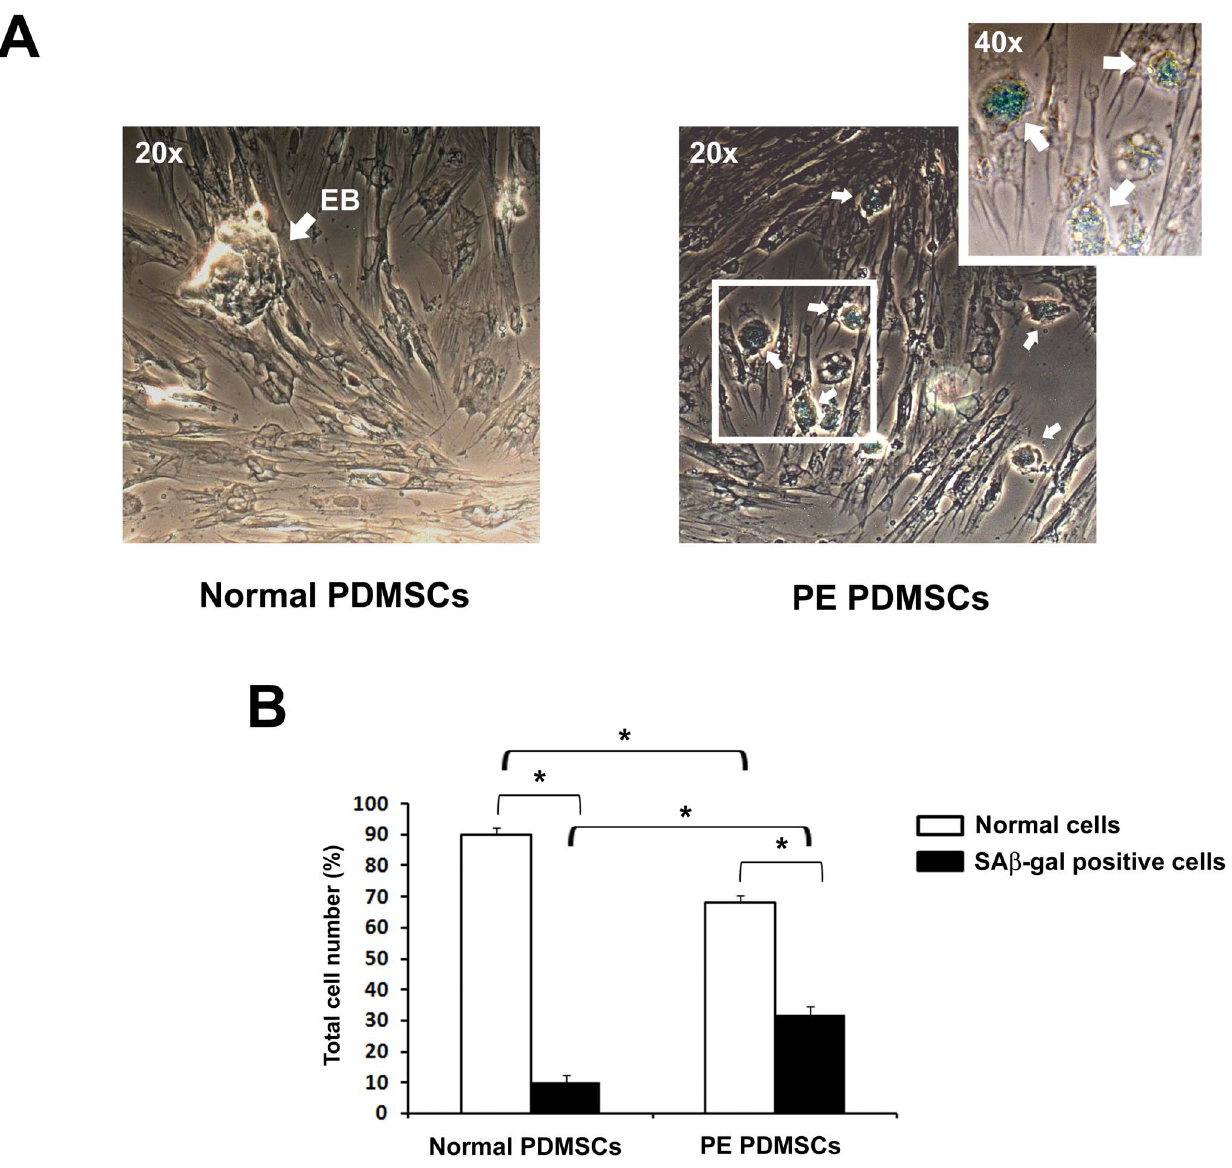
Figure 2. Senescence quantification in PDMSCs isolated from normal and preeclamptic placentae. (A) Normal (left panel) and PE (right panels) PDMSCs representative images after SA b -gal nuclear staining. EB: Embryoid Body. White Arrows indicate blu nuclei positive for SA b -gal staining, indicative of cellular senescence. (B) Quantitative analysis of cellular senescence in Normal and PE-PDMSCs. For quantitative analysis, SA b -gal positive cells were considered to be senescent cells. The percentages of senescent cells after 48 h of incubation were determined in Normal and PE- PDMSCs populations. At least 200 cells were counted in each group. Results are expressed as means 6 SE of six independent samples. Statistical significance (*) has been considered as p , 0.05.